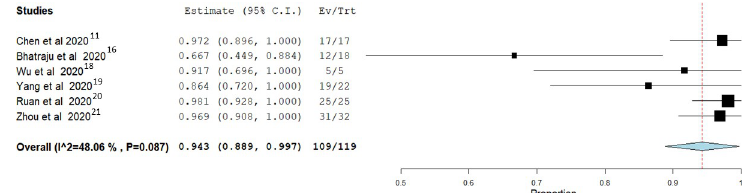
Fig 4. Meta-analysis for the six studies that reported complete outcome endpoints for all the patients who received IMV.